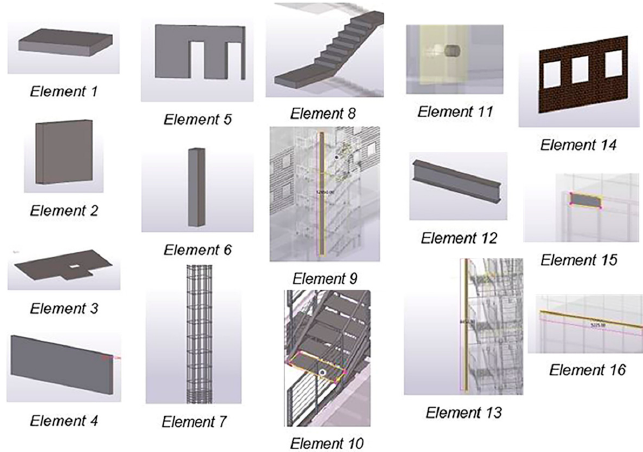
Figure 4. Elements selected from the sample model for the assessment of the data exchanges.